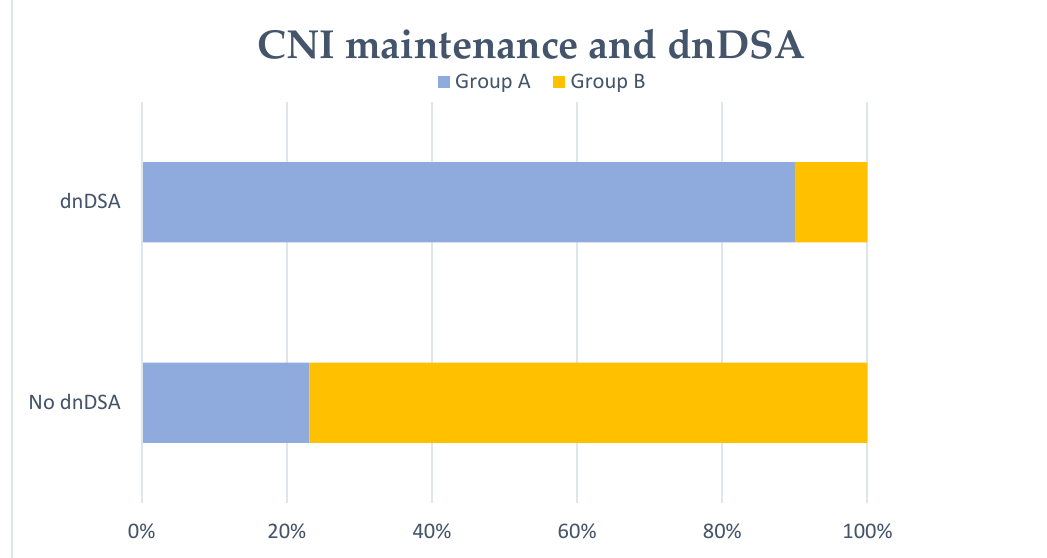
Figure 3. De novo DSA (dnDSA) development and no CNI maintenance at 6 months. No CNI maintenance at 6 months after transplant failure (group A) was significantly associated with dnDSA formation ( p < 0.001).